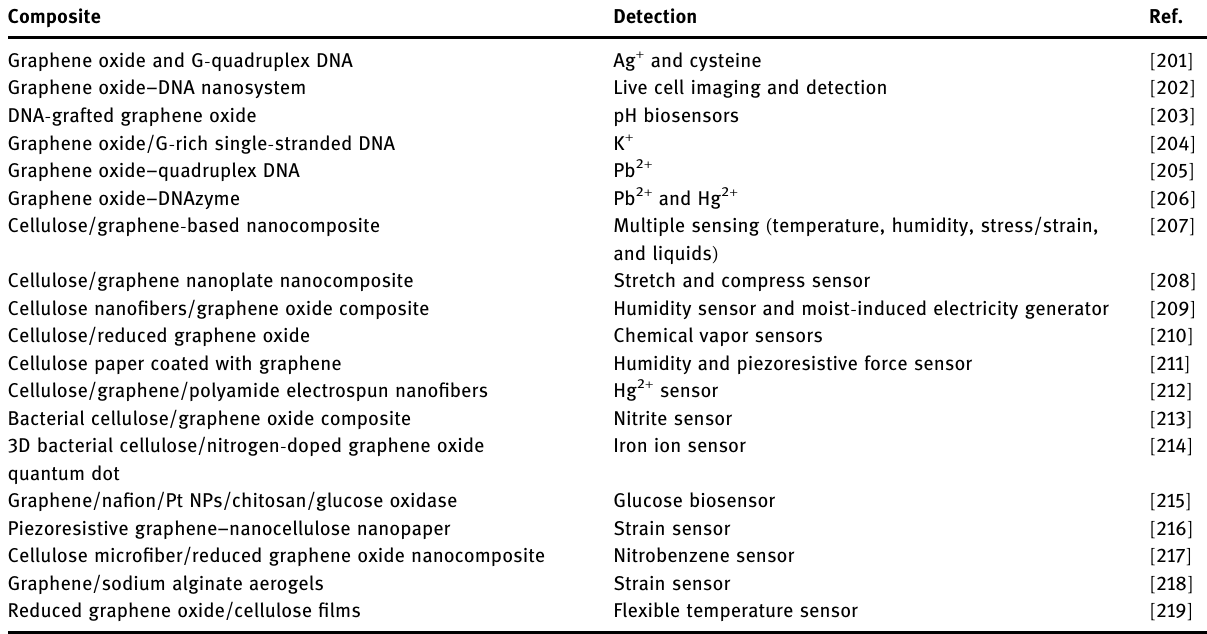
Table 3: Some biopolymer/graphene - based composites for sensor applications Composite Detection Ref.